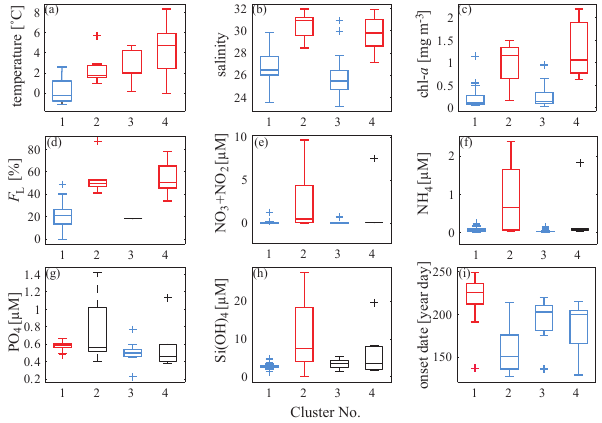
Fig. 6. Boxplots of (a) temperature, (b) salinity, (c) chl a , (d) F L , (e) NO 3 + NO 2 , (f) NH 4 , (g) PO 4 , (h) Si(OH) 4 and (i) onset date of sea ice retreat for the four clustered phytoplankton groups. Signif- icant differences ( p < 0.05) were detected by Steel-Dwass’s multi- ple comparison test between blue and red plots. Plots of the same colour and black plots are not significantly different. Note that the multiple comparison test was not conducted for F L in cluster 3 be- cause only one data point exists for that variable in that